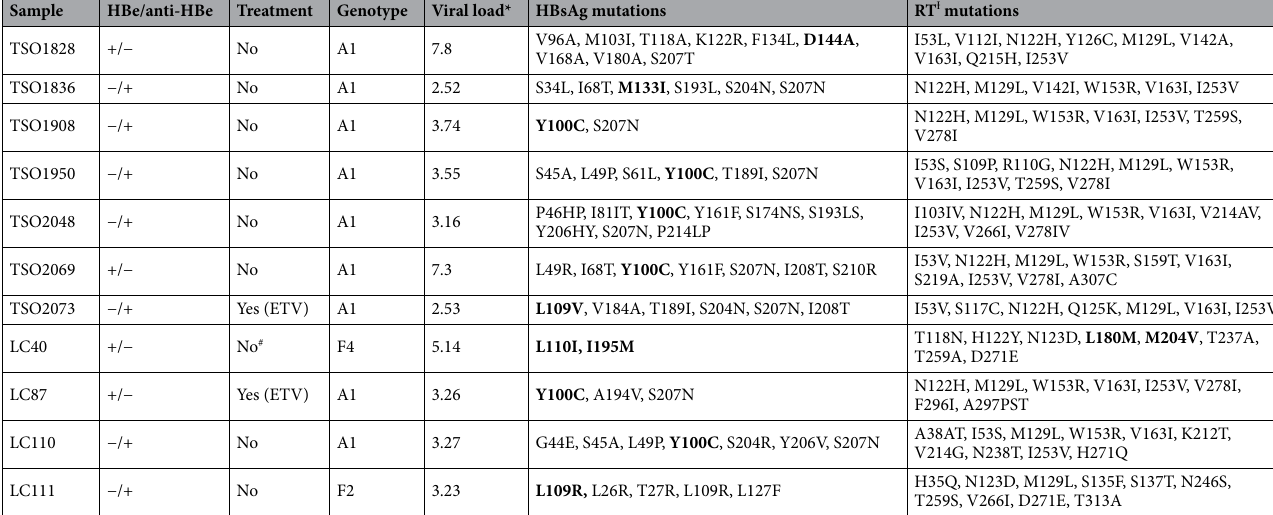
Table 7. Characteristics of samples with clinically-relevant mutations. *log UI/mL; Ɨ RT: Reverse-transcriptase; # HIV-treated patient. ETV: Entecavir. TSO: Samples from Southeast Brazil. LC: Samples from Northeast Brazil. Clinically relevant mutations are marked in bold. Significant values are in